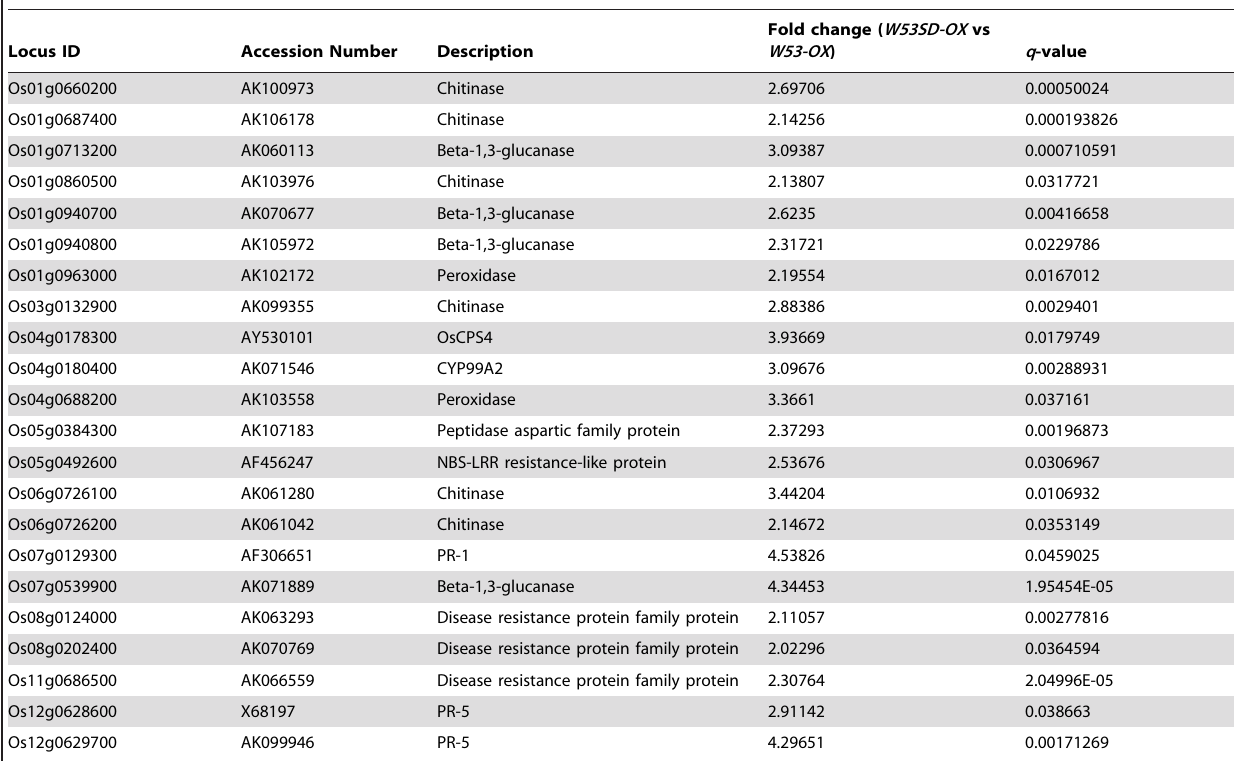
Table 1. List of defense related genes belonging to Group I.